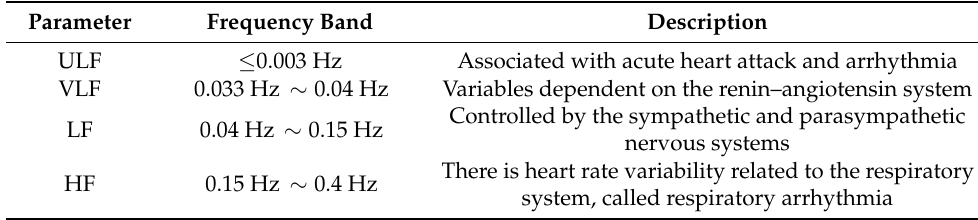
Table 1. Disease information according to the frequency band.